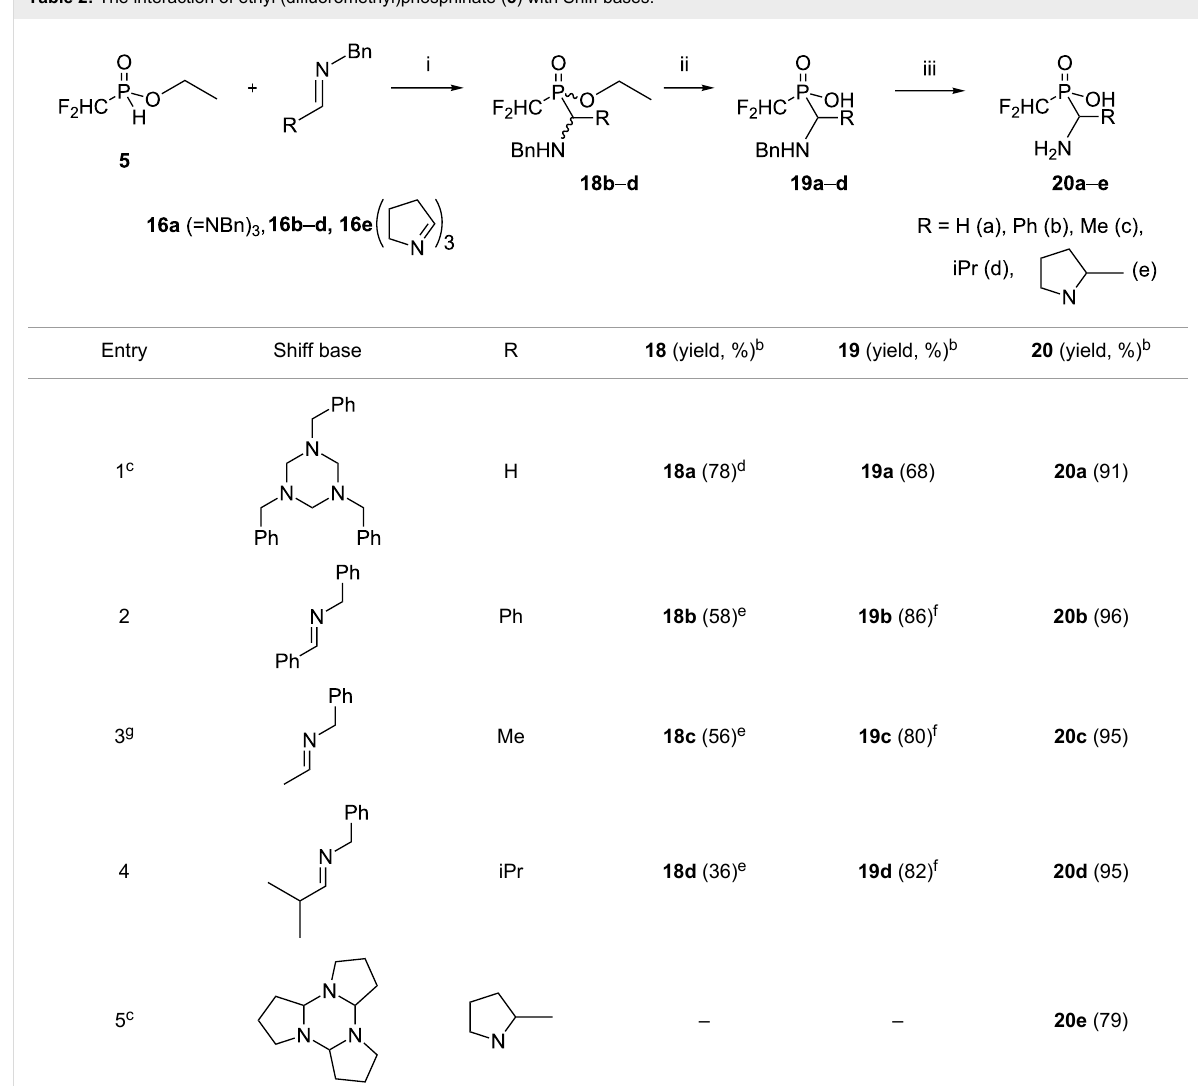
Table 2: The interaction of ethyl (difluoromethyl)phosphinate ( 5 ) with Shiff bases.